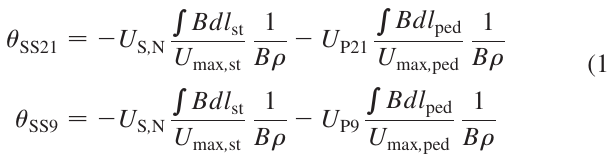
FIG. 10. Simulated closed orbit in the tracking code and zoom of the position between septum and closed orbit. The necessary fast-bump values for an equal intensity extraction turn by turn are calculated considering a bi-Gaussian beam distribution. The zoom indicates the position of SEH31 with respect to the closed orbits for each turn. adjusted manually until the equal extraction is achieved.